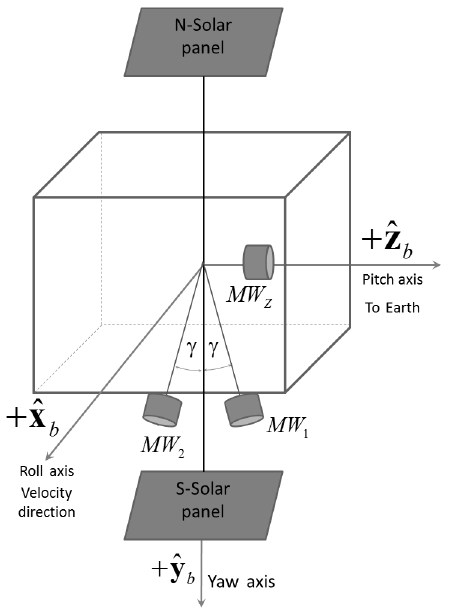
Figure 9. Momentum-biased wheel